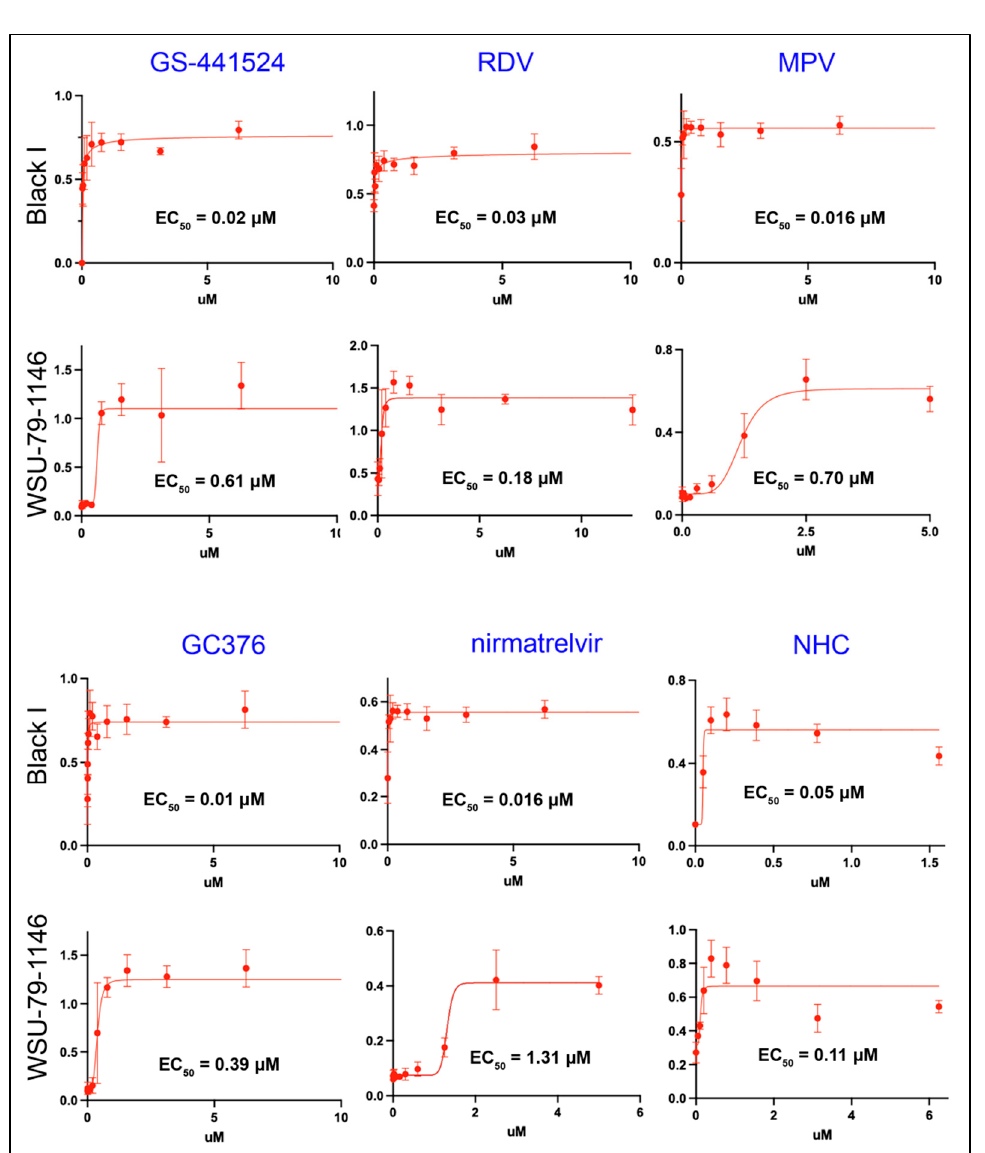
Figure 1. Compound inhibition of serotype I and II FIPV as monotherapies. Half-maximal effective concentration (EC 50 ) values for the tested nucleoside analogs and protease inhibitors against either Black I (serotype I FIPV) or WSU-79-1146 (serotype II FIPV) and corresponding non-linear regression analyses; all plate absorbance values obtained at 620 nm. For each compound concentration, the absorbance value is the mean of 6 independent wells and error bars reflect the standard deviation. Serial dilutions of each compound were performed to determine the EC 50 .